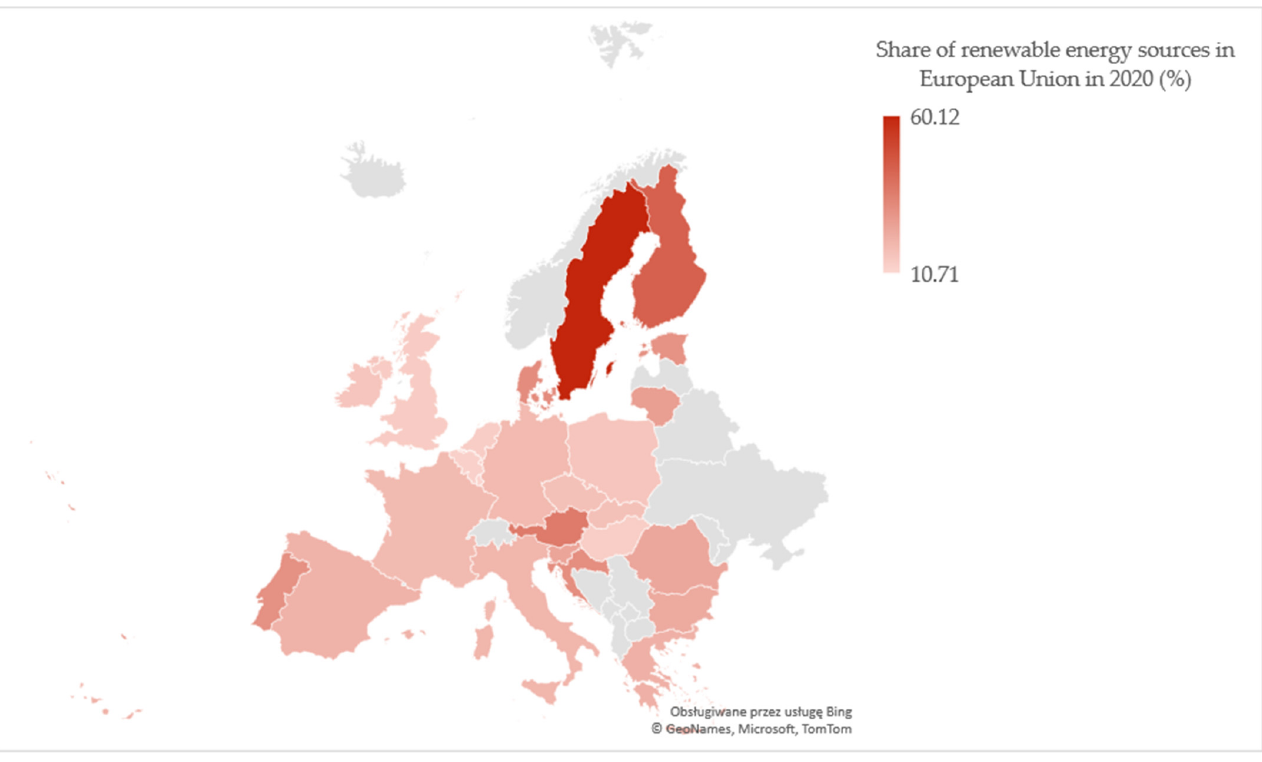
Figure 1. Share of renewable energy sources in European Union in 2020. Source: own elaborations based on [43].